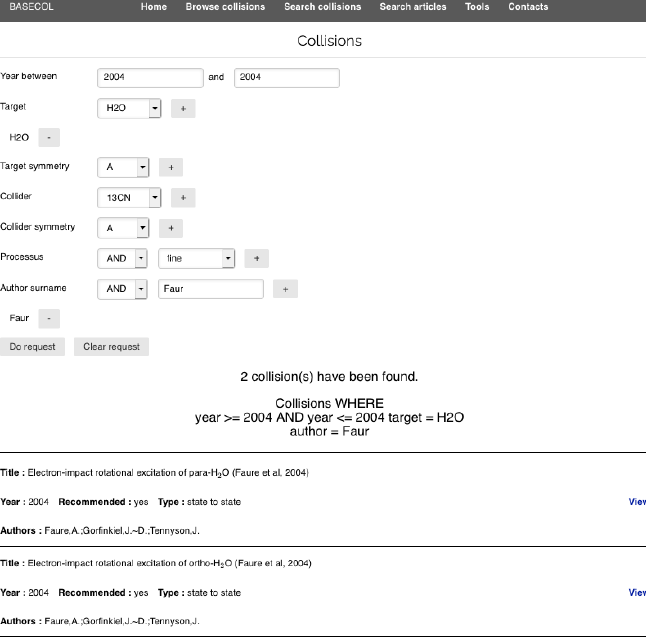
Figure 5. Query Interface with “Search Collision”. It should be noted that it is not necessary to write the full surname of the authors. The retrieved data correspond a H 2 O-electron data sets by Faure et al.